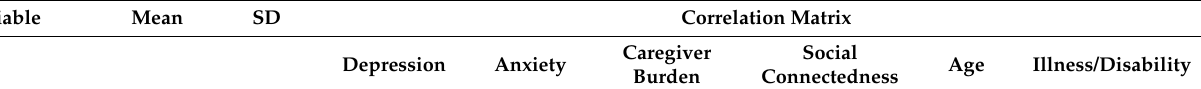
Table 2. Correlations between main study variables and continuous sociodemographic and care- related